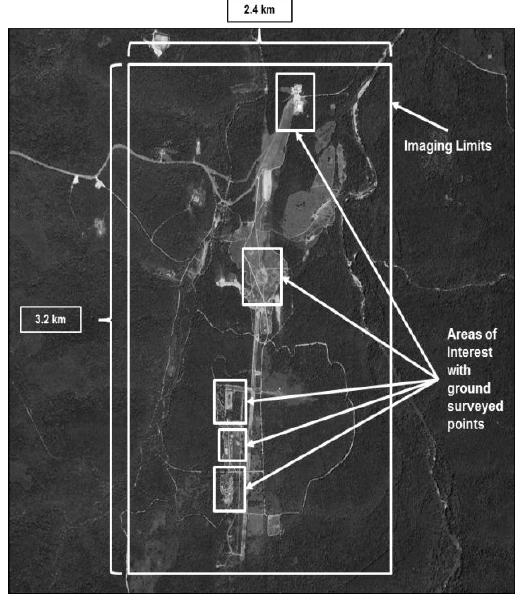
Figure 3. Sparse point cloud over northern test area depicting racetrack mode photos looking down from nadir